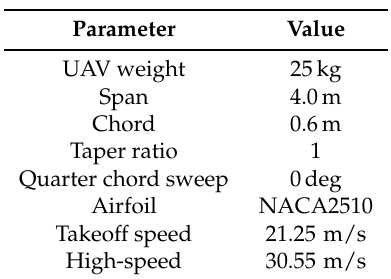
Table 1. Unmanned Aerial Vehicle (UAV) parameters.